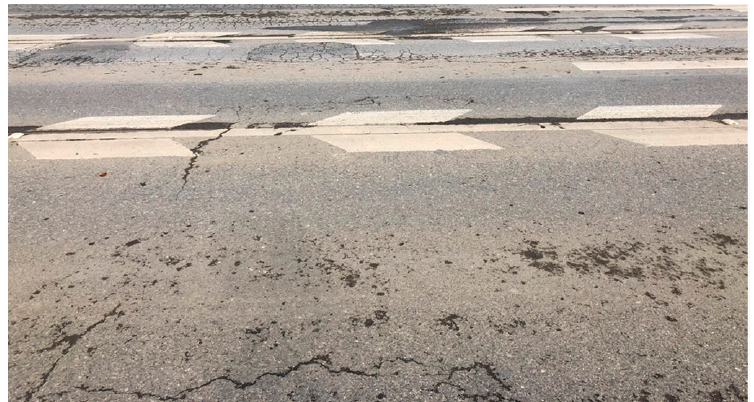
Figure 7. Cracked state of the pavement.